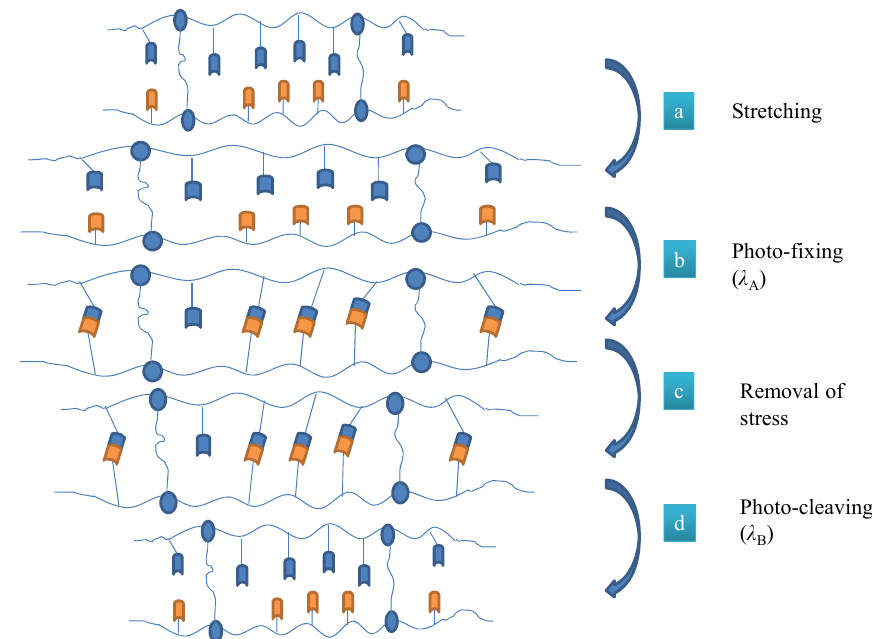
Figure 1. Schematic representing the molecular mechanism of photoinduced SMP [13], ( a ) stretching by applying stress, ( b ) photo-fixing by illumination with light of wavelength , ( c ) removal of external stress, ( d ) photo-cleaving by exposing to light of wavelength λ λ A